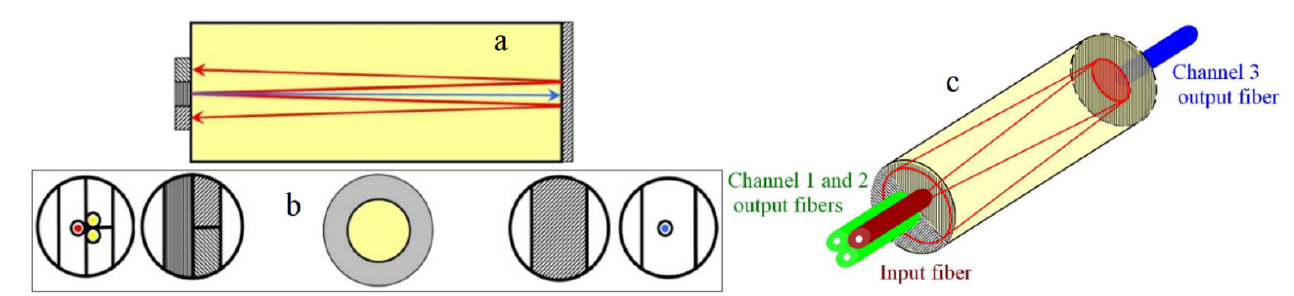
Figure 4. Measuring head that provides 2 channels (green) for the implementation of ∆ Σ normalization, and the third channel (blue) for temperature compensation by OA measurement. ( a ) Longitudinal cross-section, ( b ) transversal cross-sections and ( c ) schematic diagram.